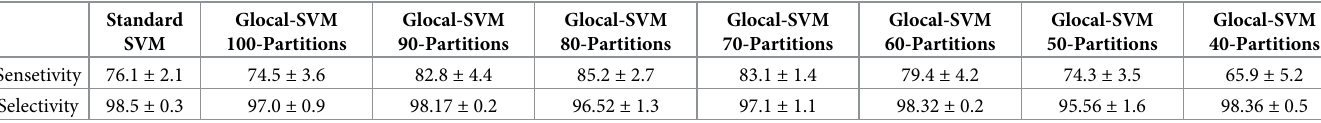
Table 2. Comparing the classification performance of the standard SVM model to the Glocal-SVM models (40-100 data-Partitions).